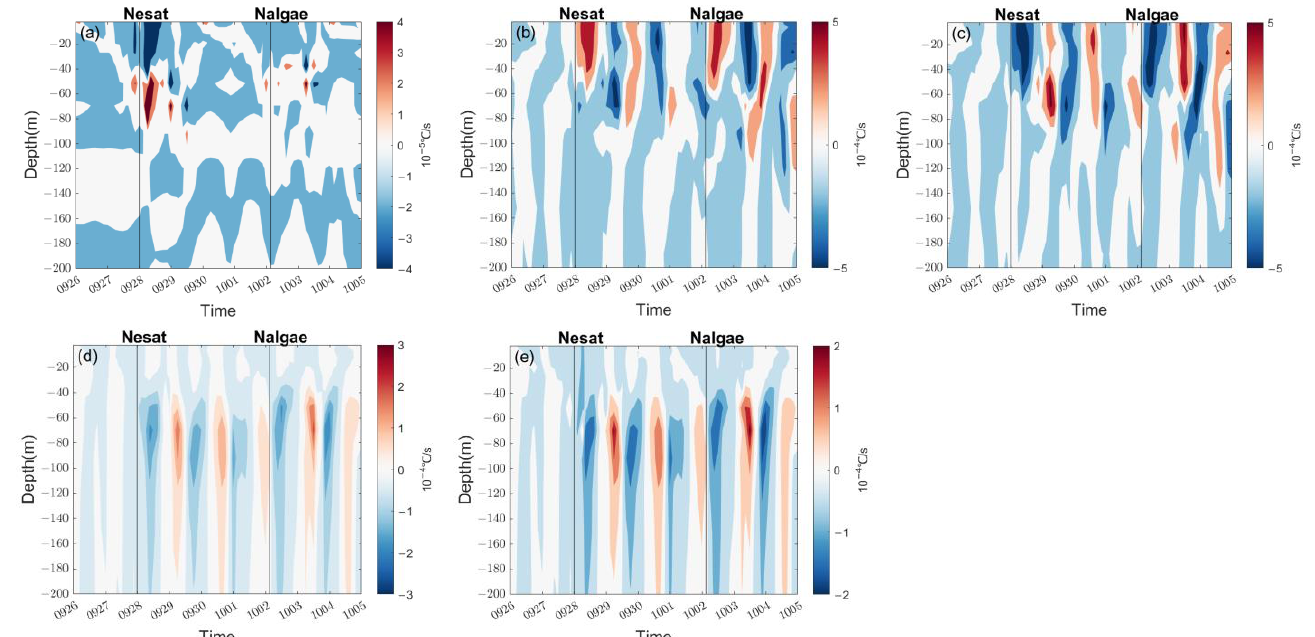
Figure 8. Ocean heat budget term at S1: ( a ) vertical diffusion; ( b ) vertical advection; ( c ) horizontal advection; ( d ) total advection; ( e ) local temperature change rate.